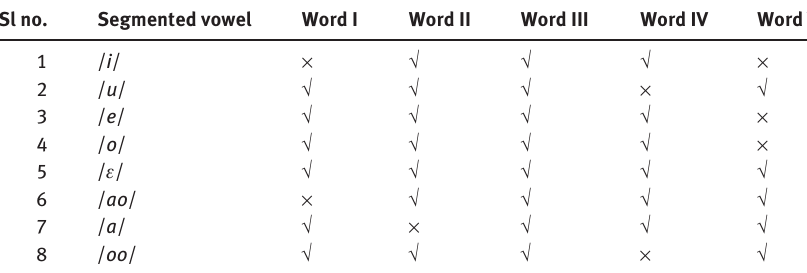
Table 9. Correct Identification of Girl Speaker 1. Sl